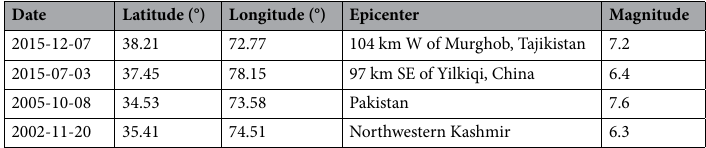
Table 1. Earthquakes that potentially triggered landslides in the study